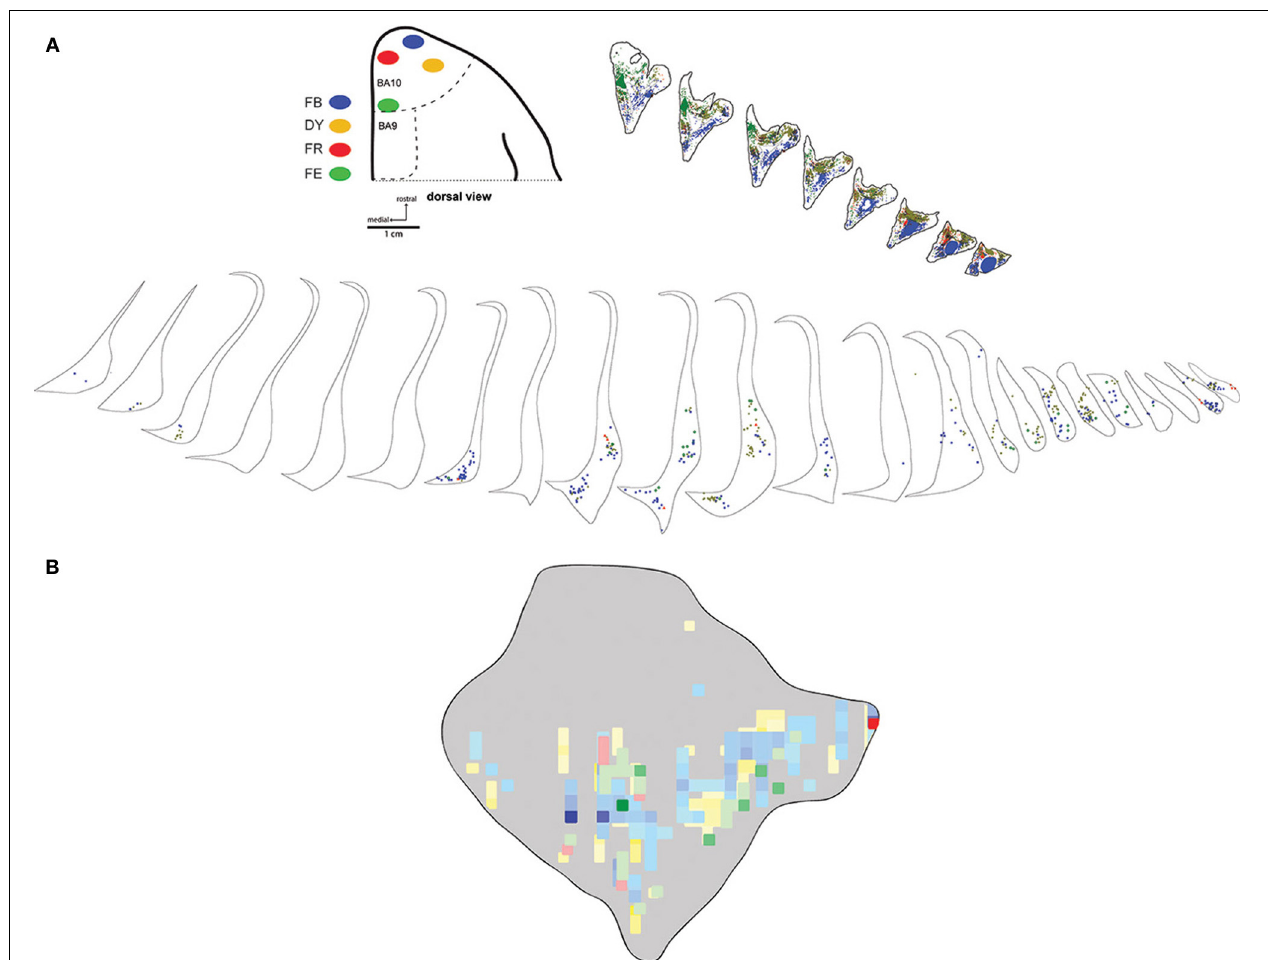
FIGURE 3 | Medial-lateral gradient of claustrum projections. Locations of 4 tracer injections in area 10 of case FR01 are shown schematically in (A) . The distributions of labeled neurons for each tracer are overlaid